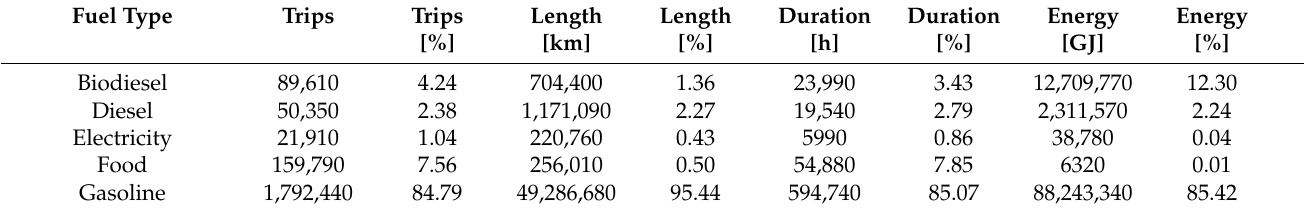
Table 3. Statistics of trips involving Santa Clara County in the baseline scenario per fuel type— interfered to the population